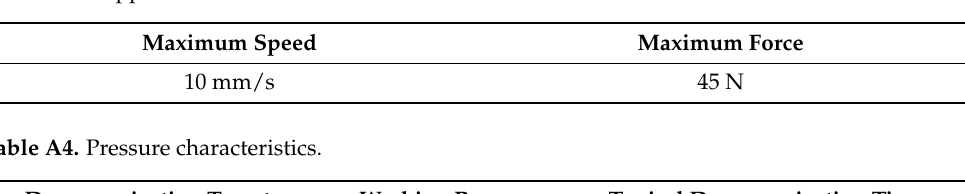
Table A3. Stepper motor characteristics.